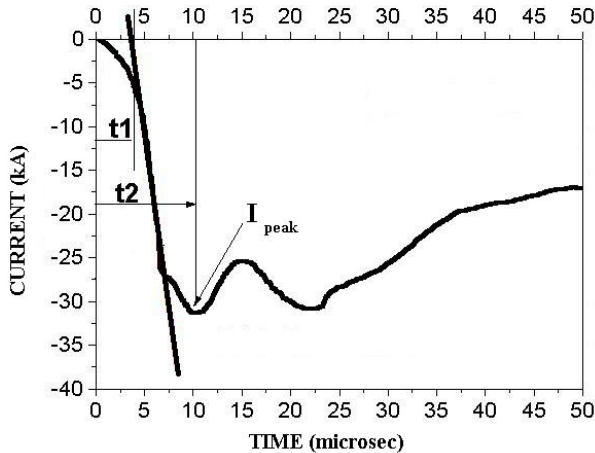
Fig. 4. Criterion adopted to determine the flash direction. It was applied for the cases that no photographic records were available or no evidence of branches are visible in the records (see text for